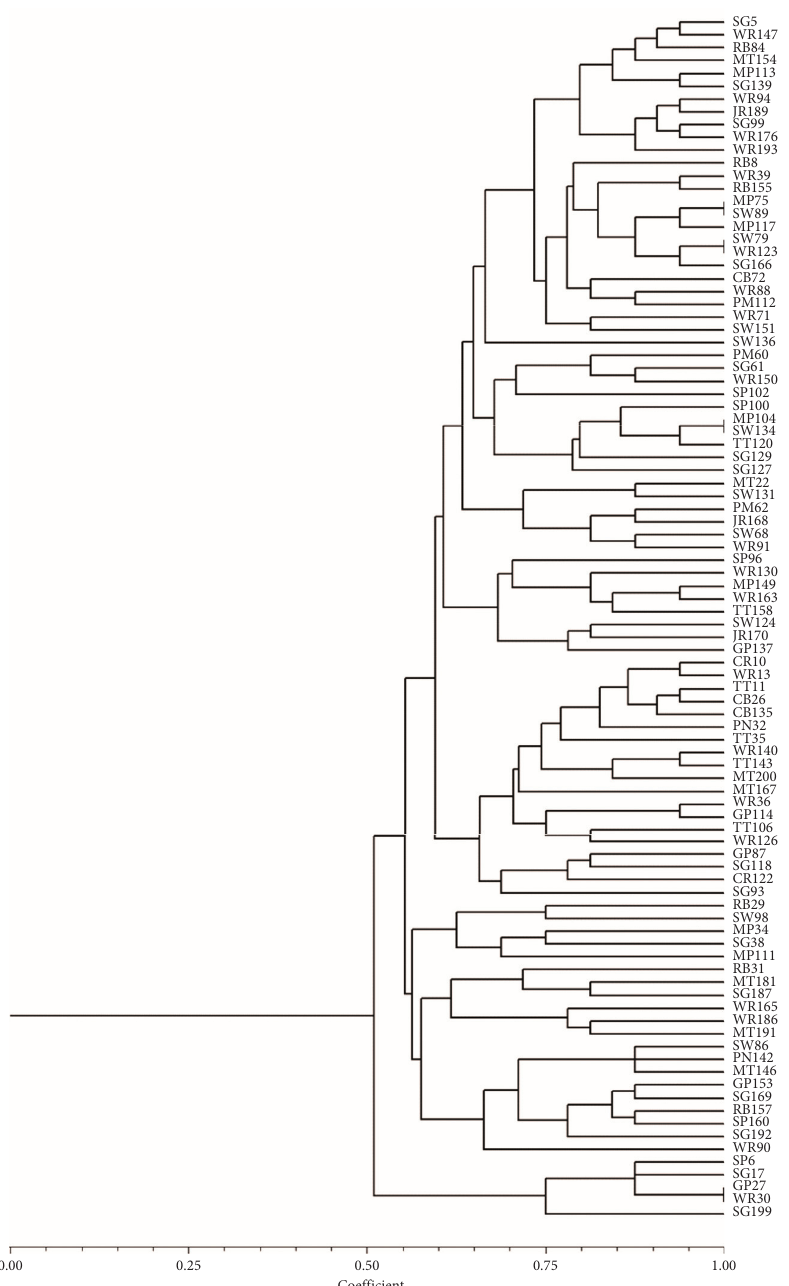
Figure 2: Dendrogram from computer-assisted analysis of RAPD-PCR profiles obtained for Bacillus cereus (Figure 1). The dendrogram generated from computer